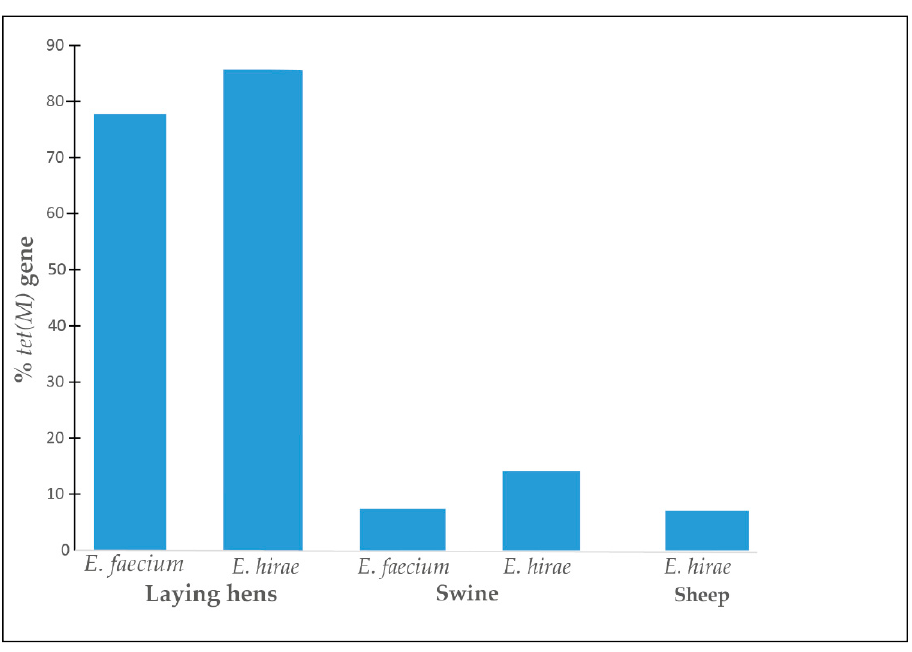
Figure 2. Prevalence of the tet(M) gene found in E. faecium and E. hirae isolates in animal